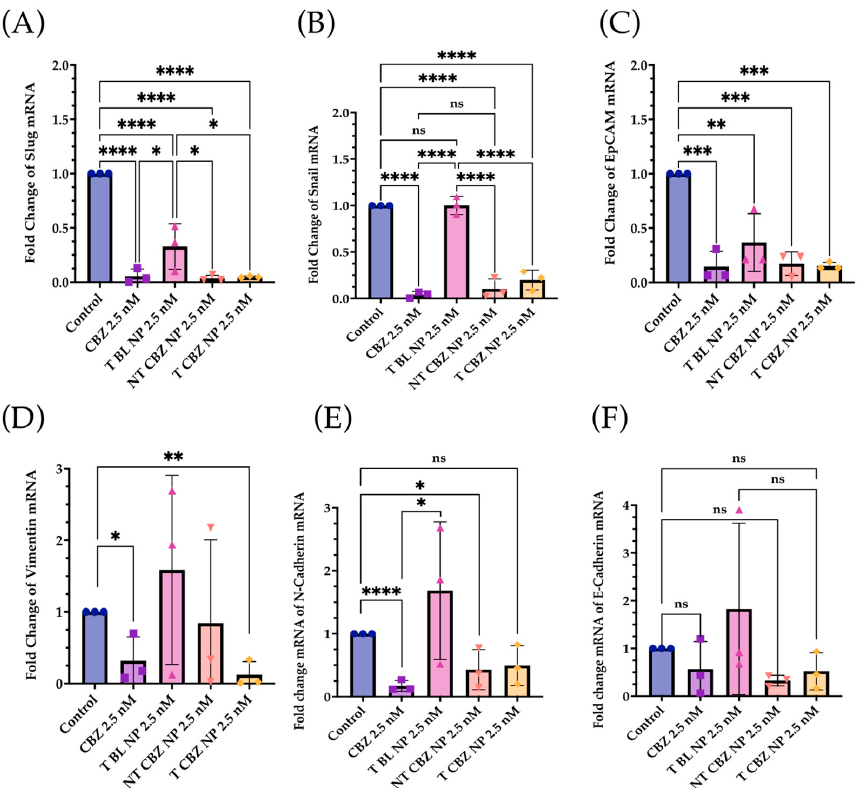
Figure 5. Gene Expression Changes. The mRNA-expression-critical EMT markers and transcription factors were downregulated by CBZ and CBZ NPs at sub-IC 50 concentrations. ( A ) Slug, ( B ) Snail, ( C ) EpCAM, ( D ) Vimentin, ( E ) N-Cadherin, ( F ) E-Cadherin. E-Cadherin was the only one that did not show significance, but there was a significant increase in its protein expression with T and NT NPs. Graphs created with GraphPad Prism 9.4. ns = not significant, * p < 0.05, ** p < 0.01, *** p < 0.001, **** p < 0.0001 (n = 3).